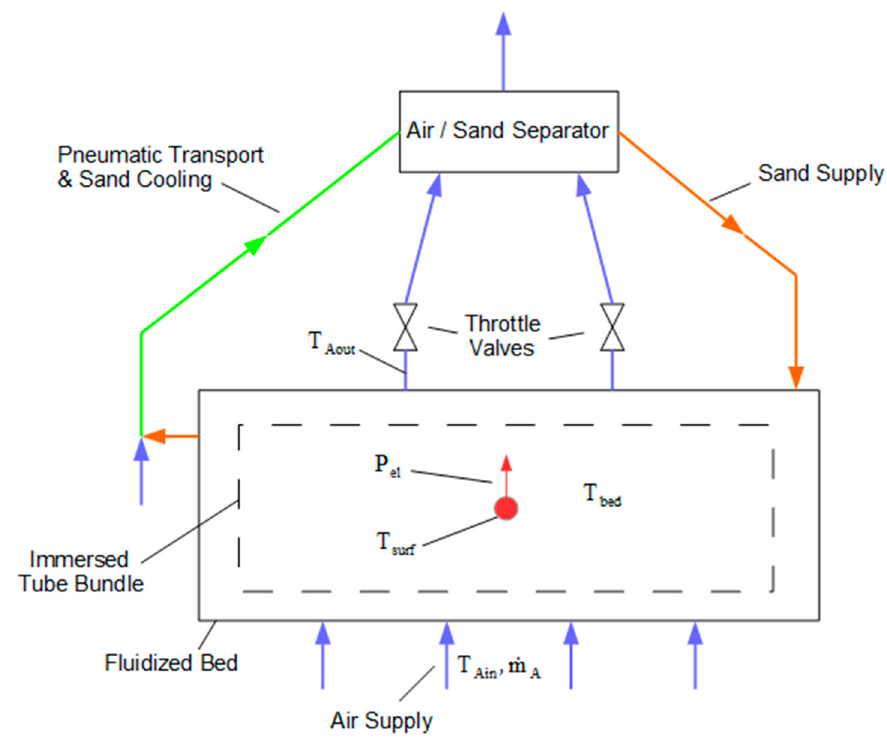
Figure 3. Generalized scheme of the test rig configuration.